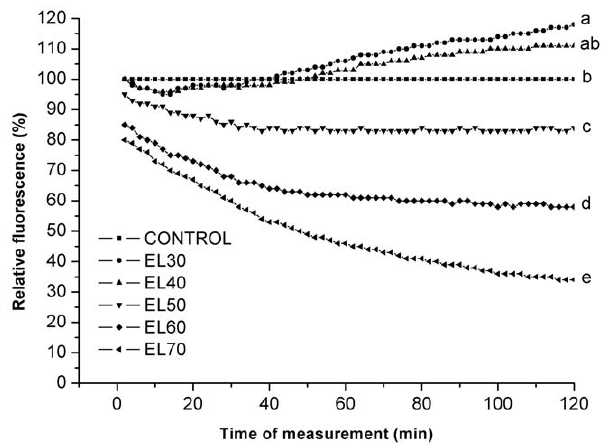
Figure 5. Cellular metabolic energy in the yeast S.cerevisiae treated with EE96 and EL30 to EL70 eluates (1%). Data are means 6 S.D. (n=3) and are expressed as luminescence relative to control. Values followed by the same letter (a–e) are not statistically different (P , 0.05), as measured by Duncan’s test.